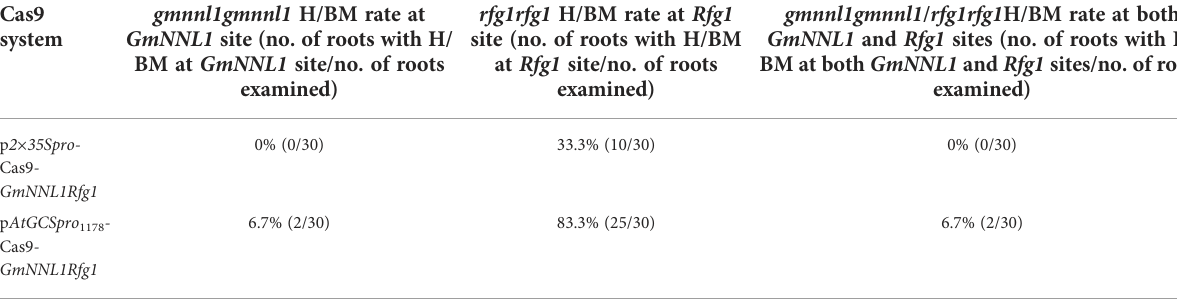
TABLE 3 Comparison of p AtGCSpro 1178 -Cas9 -GmNNL1Rfg1 and p 2×35Spro -Cas9 -GmNNL1Rfg1 genome editing ef fi ciency in soybean hairy roots. Cas9